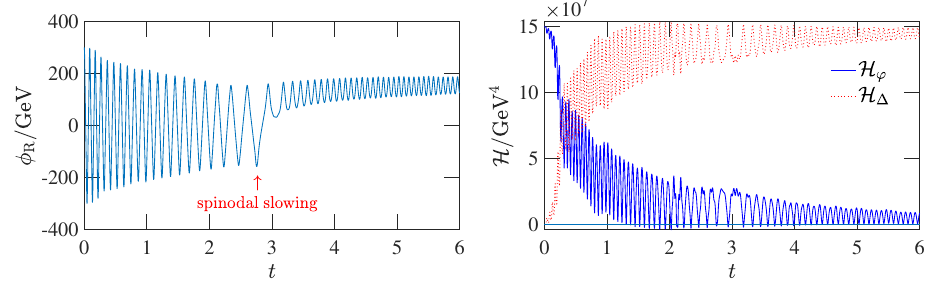
Figure 8 . Shown is the time-evolution of the classical field (left panel) and that of the total energy in the fluctuations and the classical field (right panel). H ϕ ( t ) is the energy in the classical field and H ∆ ( t ) is the energy in the fluctuations. The physical parameters and the specific form of the collision integrals used in this run are described in the